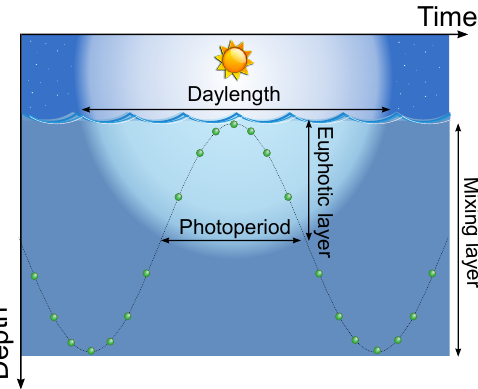
Figure 5. Schematic of the trajectory of phytoplankton cells in the mixing layer. The photoperiod is the time spent by the cell in the eu- photic layer. In the open ocean, this time depends on the day length, the depth of the euphotic layer, the strength and the vertical extent of the turbulence mixing the